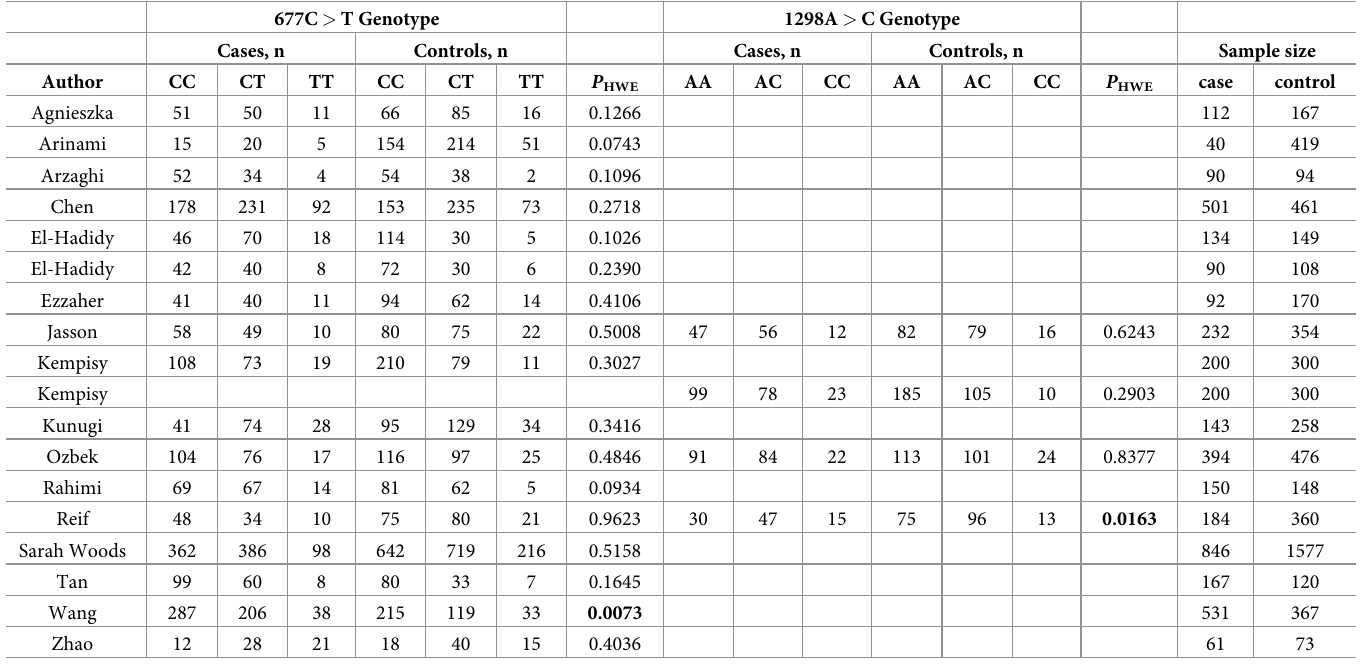
Table 3. Distribution of genotype and allele frequencies of the MTHFR 677C > T and 1298A > C polymorphisms in bipolar disorder patients.